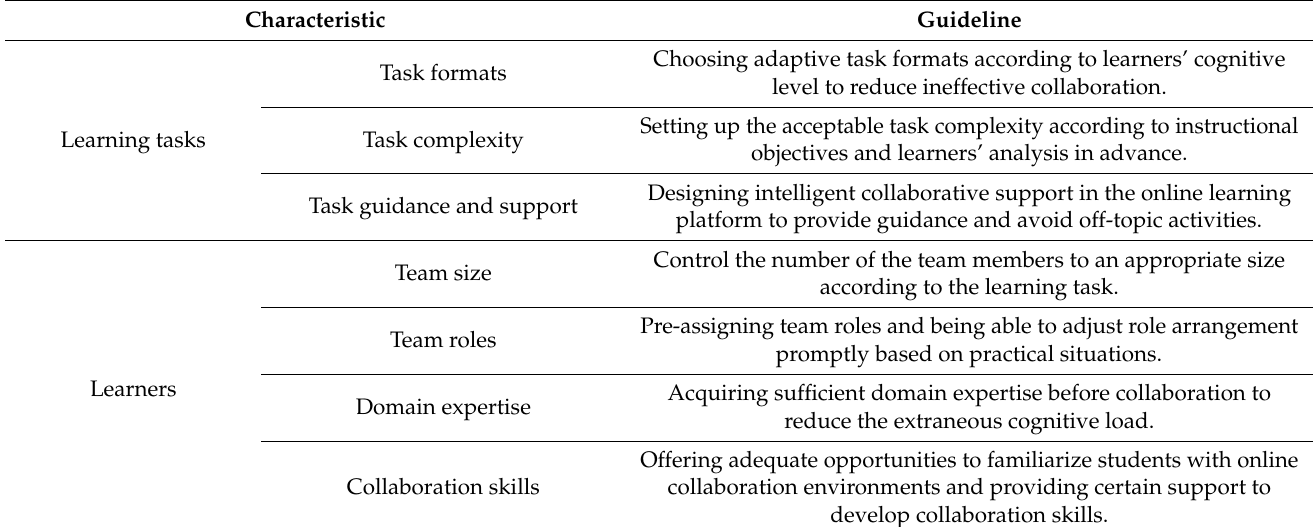
Table 1. Online collaborative learning